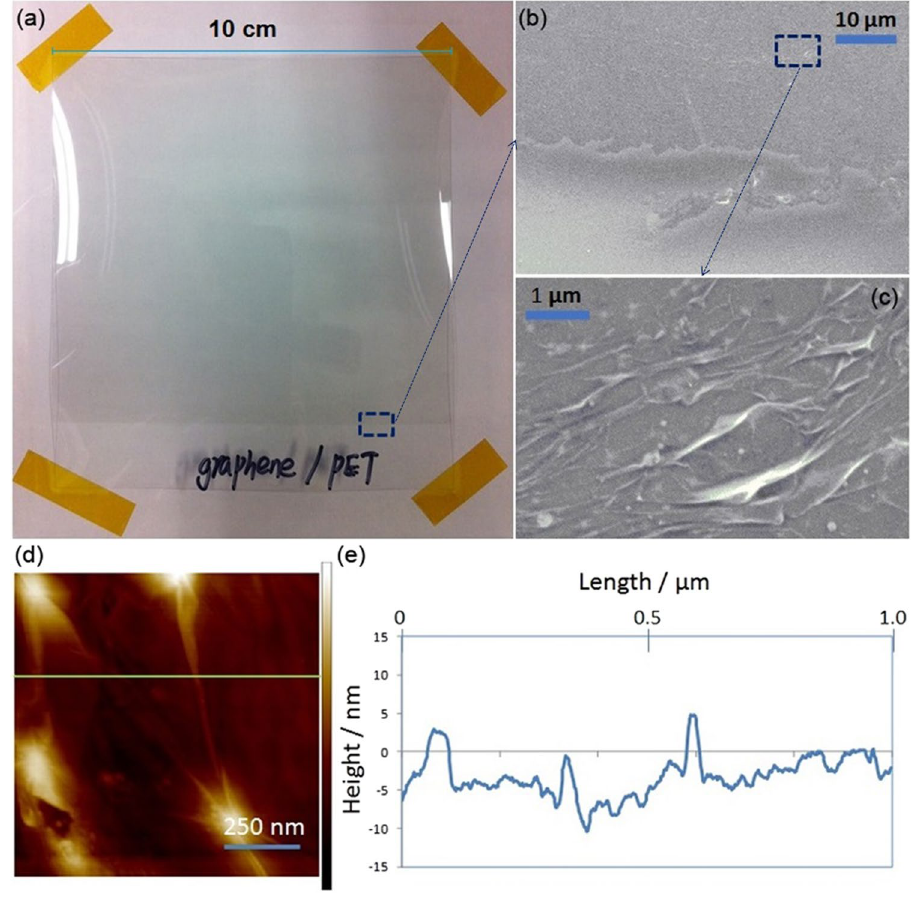
Figure 2. ( a ) A photographic image of graphene/PET composite; ( b ) SEM of graphene/PET composite; ( c ) enlarged SEM image of selected area on graphene/PET composite; ( d ) AFM images of graphene/PET composite and ( e ) height profile of graphene film coating along the green line in ( d ).